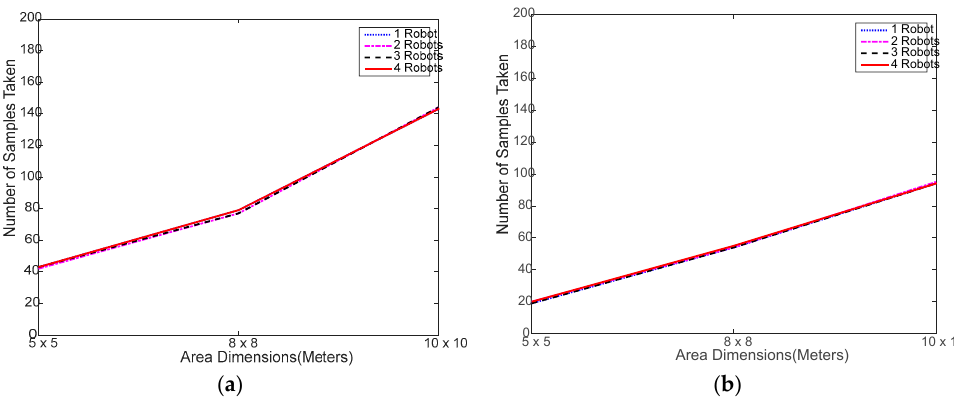
Figure 9. Number of samples collected in the simulation testing: ( a ) using distributed WiMAP algorithm; ( b ) using distributed DWiMAP.